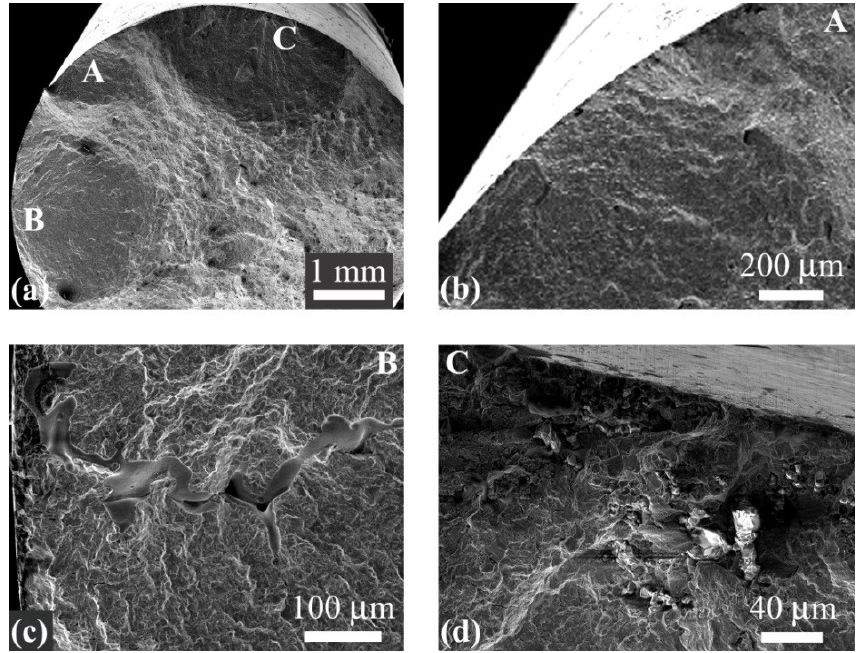
Figure 7. SEM images of the fracture surface for the dogbone specimen with multi-site crack initiation, σ a = 380 MPa, N = 2.38 × 10 3 . ( a ): Fracture surface with low magnification; ( b – d ) Close-ups of crack initiation regions A, B, and C in ( a ).